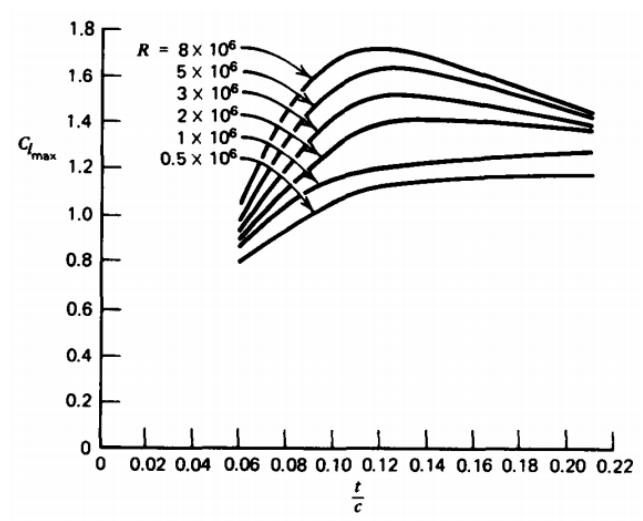
Figure 8. Effect of low Reynolds number on lift coefficients of typical wing section (NACA24xx series) .